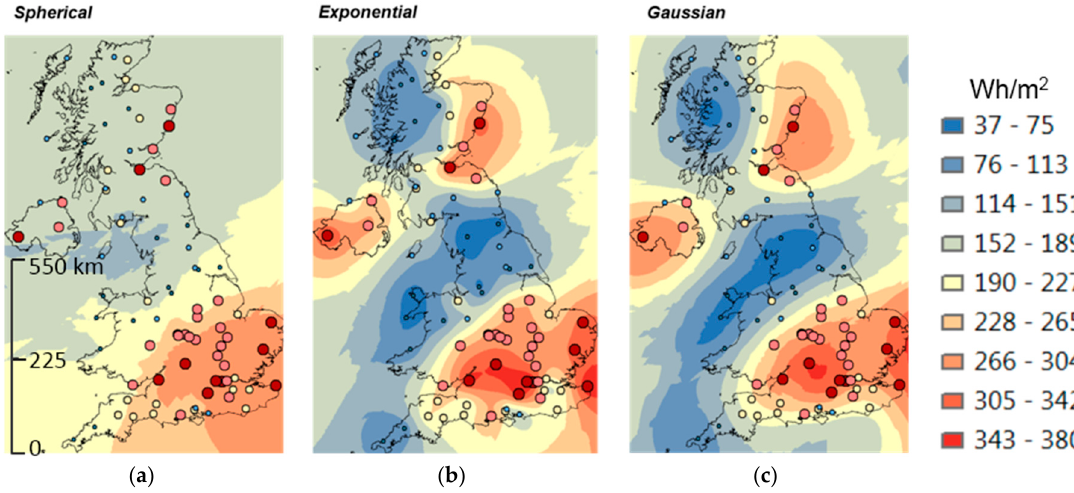
Figure A3. Output surfaces of hourly global irradiation for 11:00 a.m. on 1 January 2012 produced by three kriging semi-variograms: ( a ) spherical; ( b ) exponential; and ( c ) gaussian.